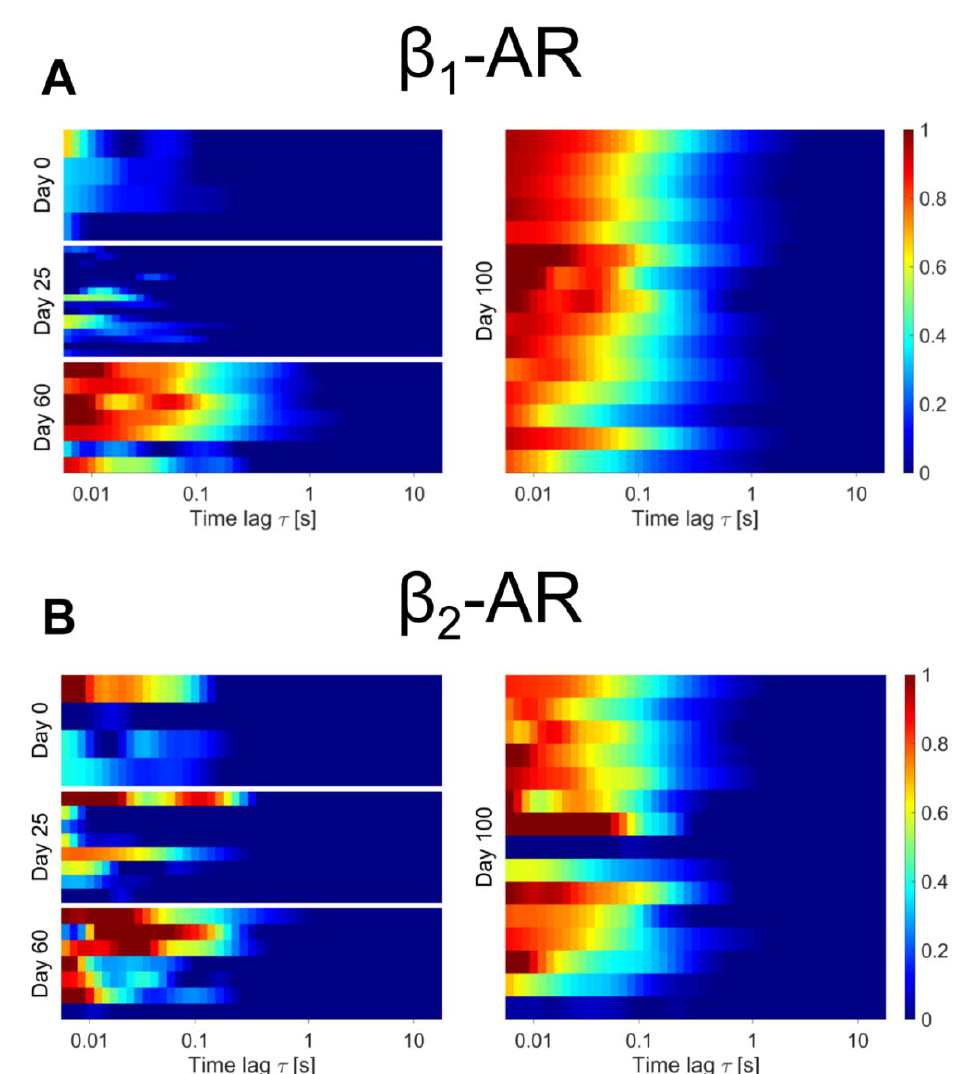
Figure 3. Linescan-FCS evaluation of β 1 -ARs ( A ) and β 2 -ARs ( B ) in WT hiPSC-CMs at day 0, 25, 60 and 100 of maturation. Colorscale indicates the amplitude of normalized autocorrelation (ACF) curves. Normalization was to each G(0) or highest peak of the curve (See Materials and Methods Section). Each bar represents the average correlation arising from the scan at the surface of one cell. For each day a minimum of at least four scans of different hiPSC-CMs was evaluated (n for β 1 -/ β 2 -AR at day 0 = 4/4, day 25 = 16/8, day 60 = 7/7, day 100 = 15/15).